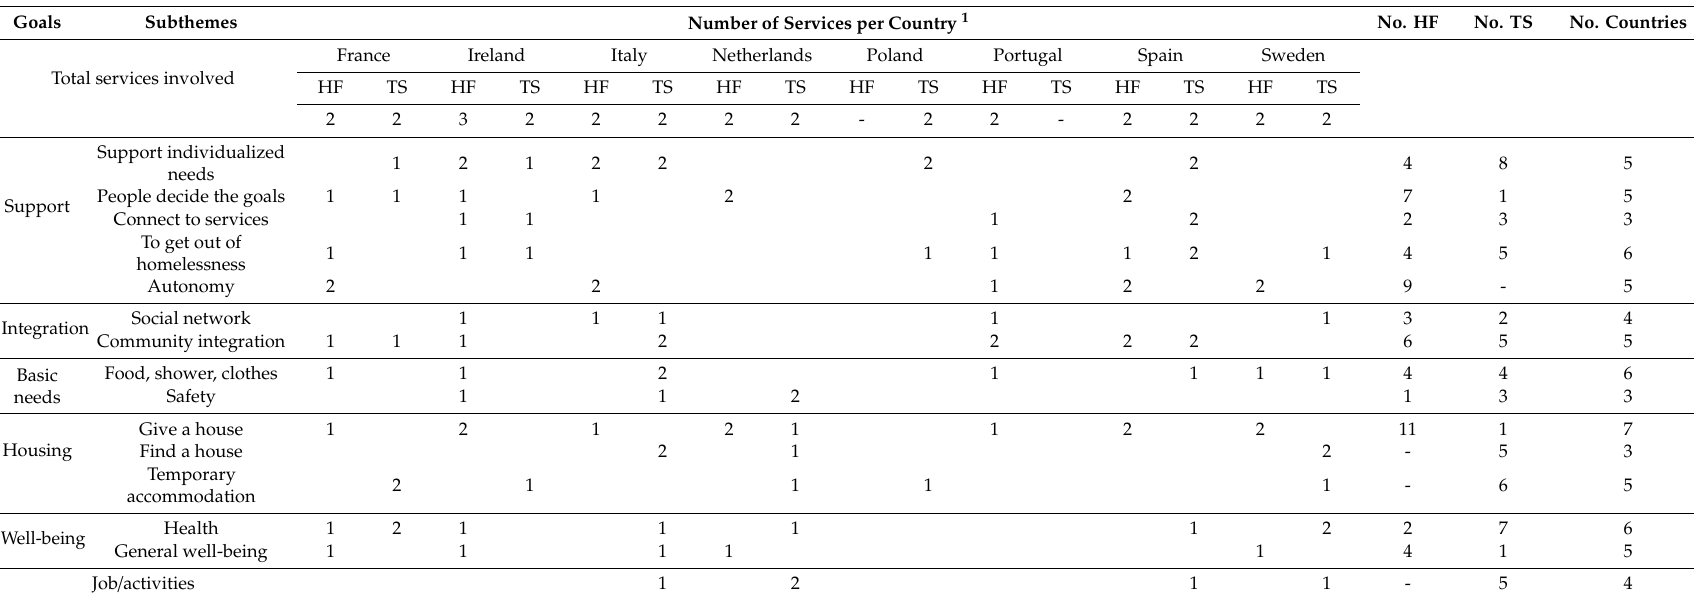
Table 4. Service’s goals emerged within HF and TS programs in eight European